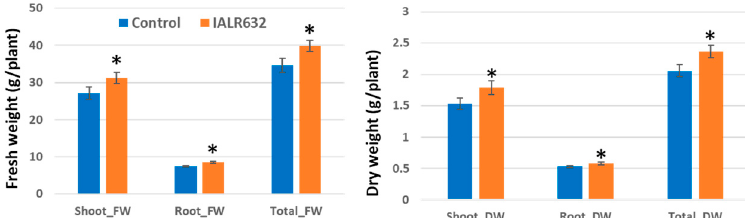
Figure 6. Effects of IALR632 inoculation on growth of Green Oakleaf lettuce in DWC hydroponic system in greenhouse (26 January 2022 to 16 February 2022). * on the column means statistically significant difference at p < 0.05.